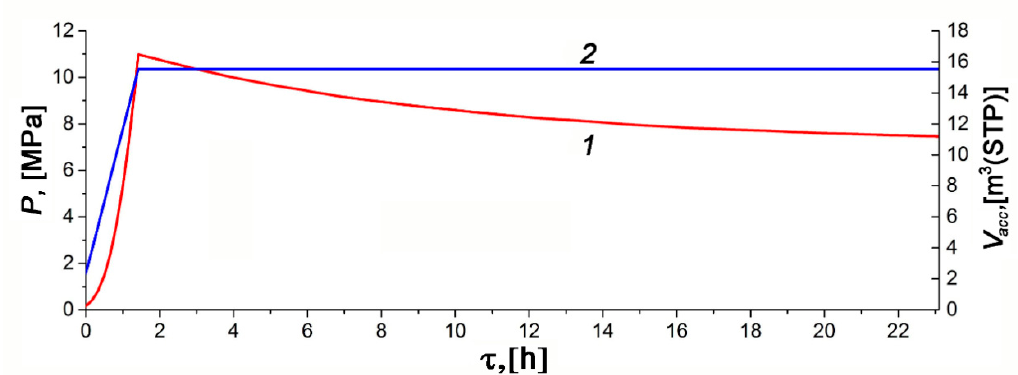
Figure 11. Temporal variations of pressure (1) and the amount of gas stored in the ANG tank (2) during the charge cycle calculated for the thermally insulated conditions.